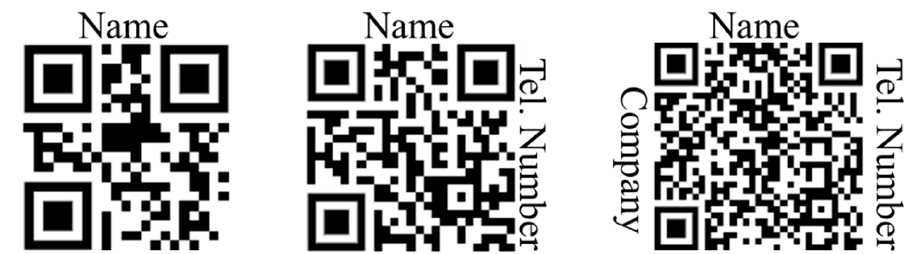
Figure 3. QR code pixel changing according to the amount of information contained.